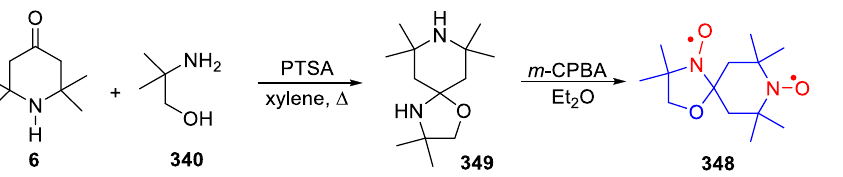
Figure 13. Examples of DOXYL-type SNRs synthesized by the method of Keana et al. The colored numbers indicate the yields—blue for the cyclic amine, and green for the radical. Spiro-fused heterodiradical 348 is obtained